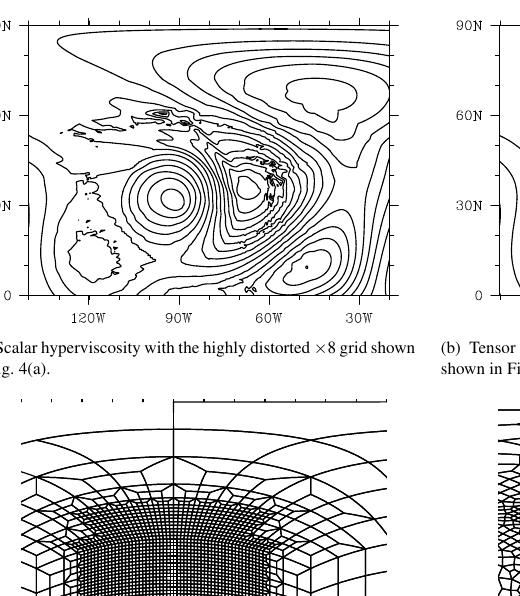
Figure 8. As in Fig. 7 but plotted in a subregion of the global domain.